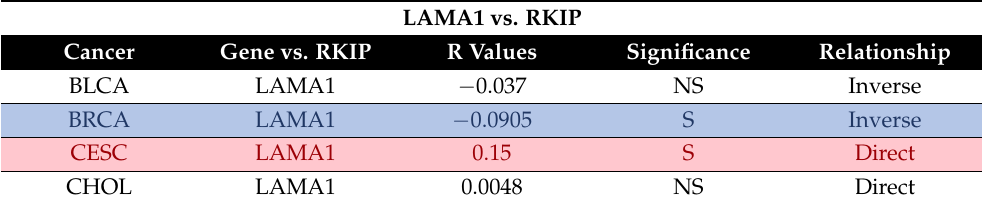
Blue: Significant Inverse Relationship; Red: Significant Direct Relationship. Table 6. RKIP vs. LAMA1. A bioinformatic analysis was performed across 23 different cancer types comparing the presence of RKIP against VIM. From this data, a p -value and an R value were determined for each of the cancer types. The table above organized the bioinformatic data. For each cancer type, the R value was reported in the third column. Significance was determined based on the p -value, with a p -value less than 0.05 indicating a significant value. The relationship between RKIP and LAMA1 was determined through the sign of the R value. A negative R value indicated an inverse relationship while a positive R value indicated a direct relationship. The rows highlighted in blue indicate a significant, inverse relationship between RKIP and LAMA1. The rows highlighted in red indicate a significant, direct relationship between RKIP and